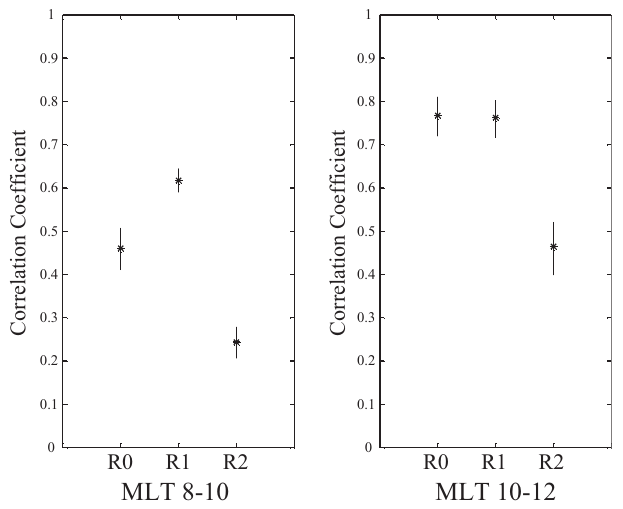
Fig. 5. Shows the correlation coefficient between the B A displacement and the ionospheric conductivity calculated from Mehta’s equation for R0, R1 and R2 for the 8–10h (left panel) and 10–12h (right panel) MLT bins. The vertical segment around the star shows the error bar calculated by using the bootstrap